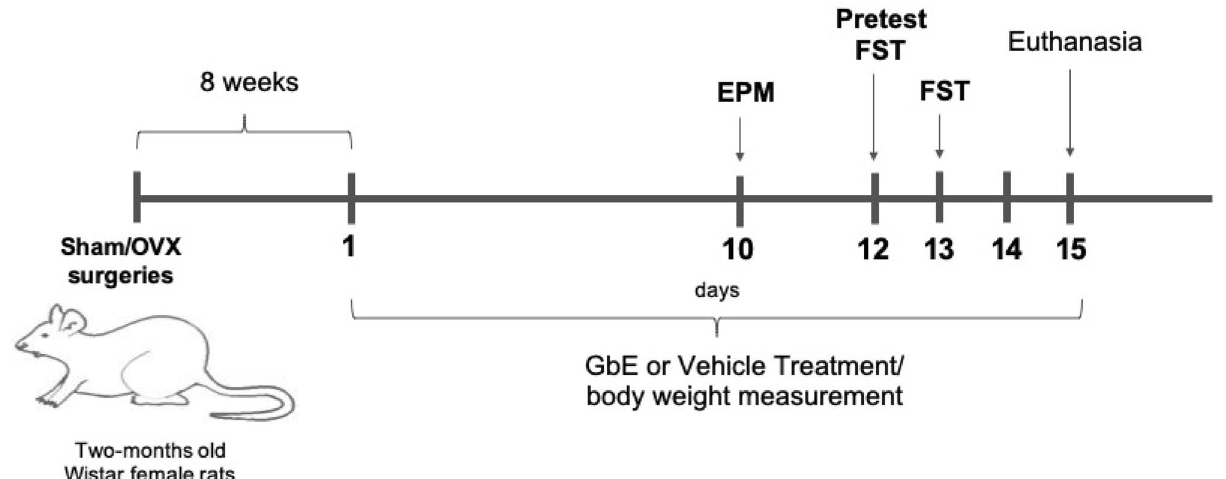
Figure 6. Experimental